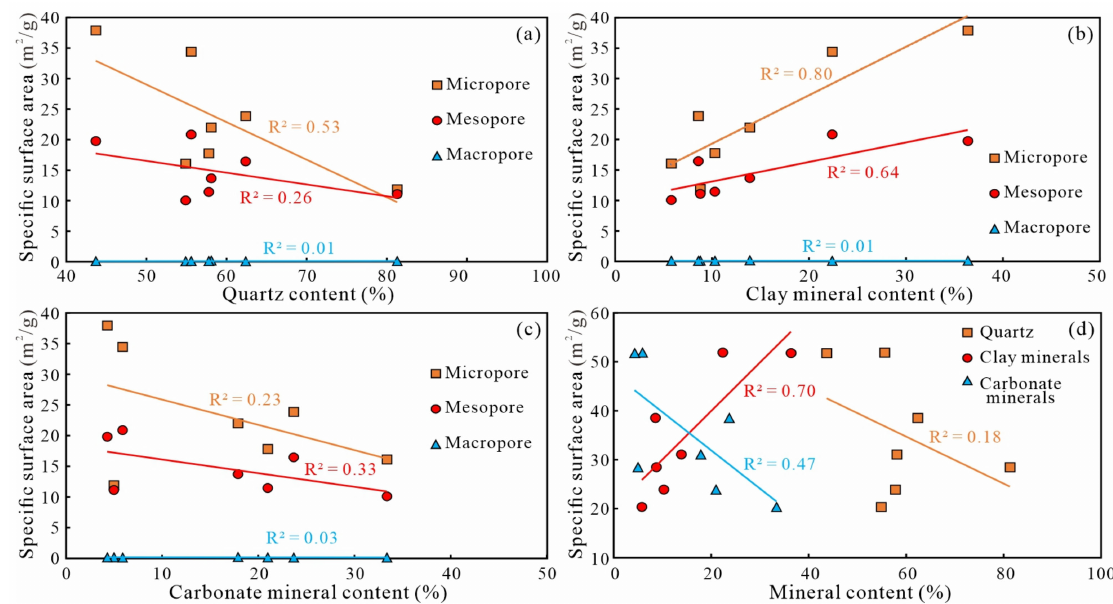
Figure 13. Correlations between pore-specific surface areas and mineral contents in the Dalong Formation. Correlations are shown between pore-specific surface area, separated by pore size class, and ( a ) Quartz, ( b ) Clay mineral, ( c ) Carbonate mineral contents, and ( d ) Between overall pore-specific surface area and individual mineral